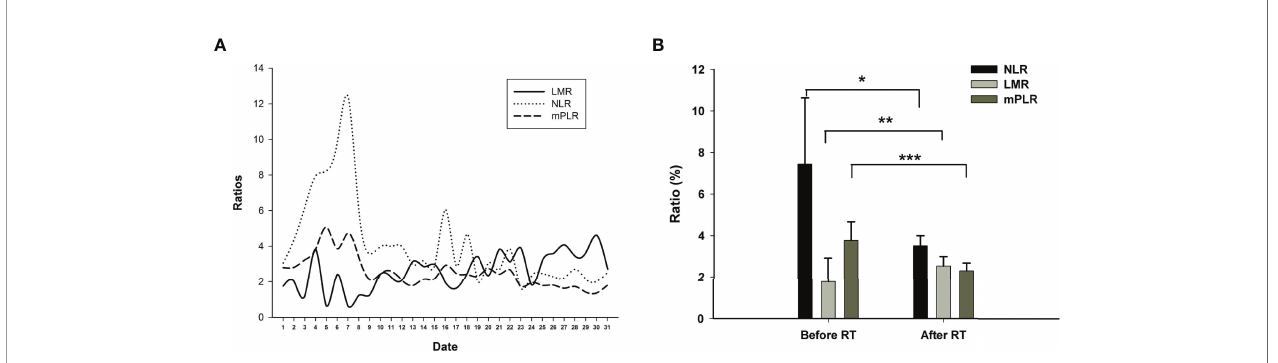
FIGURE 3 | (A) The variations in ratios for LMR (lymphocyte to macrophages ratio), NLR (neutrophils to lymphocyte ratio), and mPLR (modi fi ed platelet to lymphocyte ratio, platelet to lymphocyte ratio/50) from July 3, 2020 (No. 1 at x-axis) to August 31, 2021 (No. 31 at x-axis). (B) The means of LMR, NLR, and mPLR